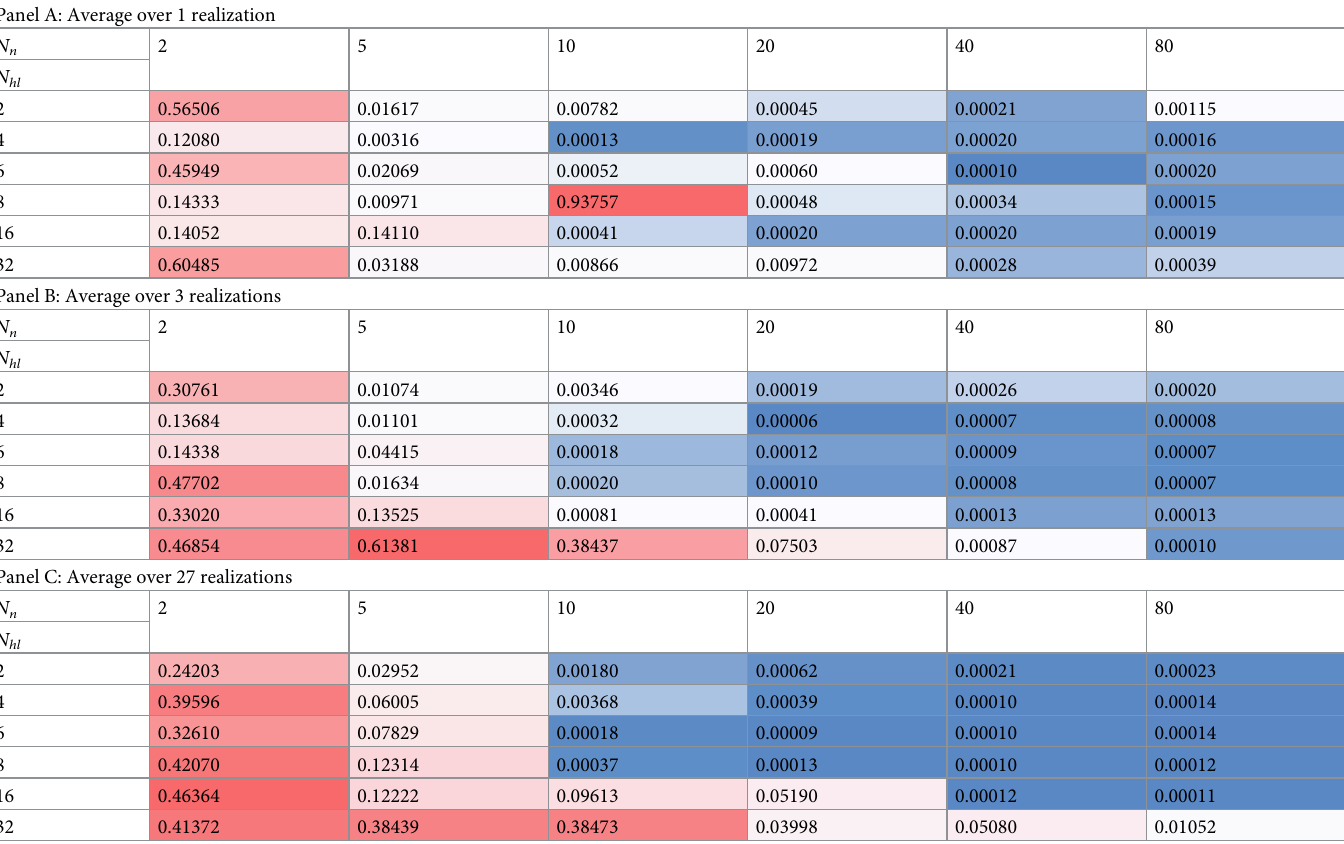
Table 6. Biot’s equations—forward modeling: PINN performance as function of hyperparameters. Sum of relative L 2 errors between the exact and predicted values of u , v , and p for the validation set. The table shows the dependency on the different number of hidden layers, N hl , and different number of neurons per layer, N n . Here, the total number of training and collocation points is fixed to N = 96 and N P = 160, respectively. b Panel A: Average over 1